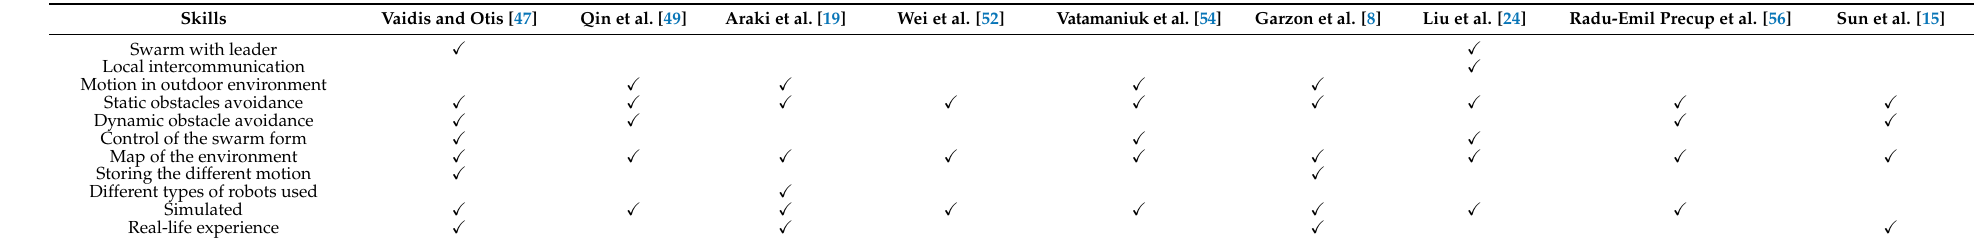
Table 2. Comparison of the different deterministic algorithms for centralized